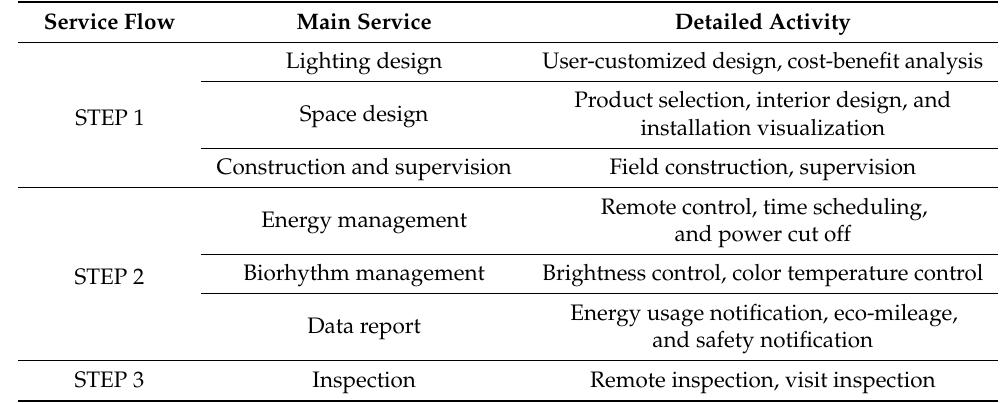
Table 1. Content of Smart Space Service.